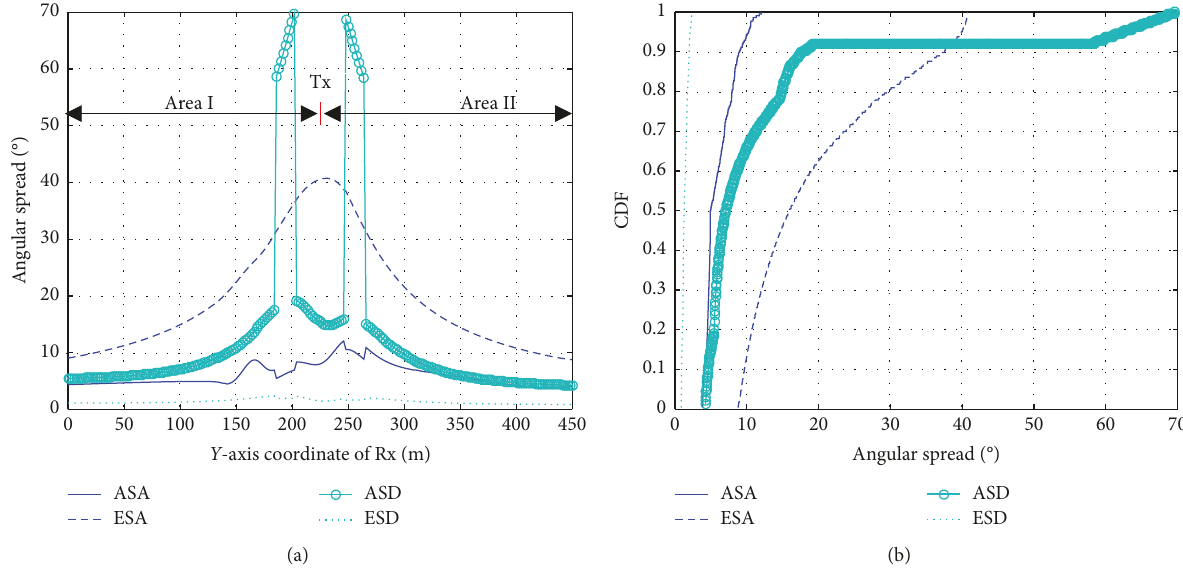
Figure 7: (a) RMS angular spread. (b) CDF of RMS angular spread on Line